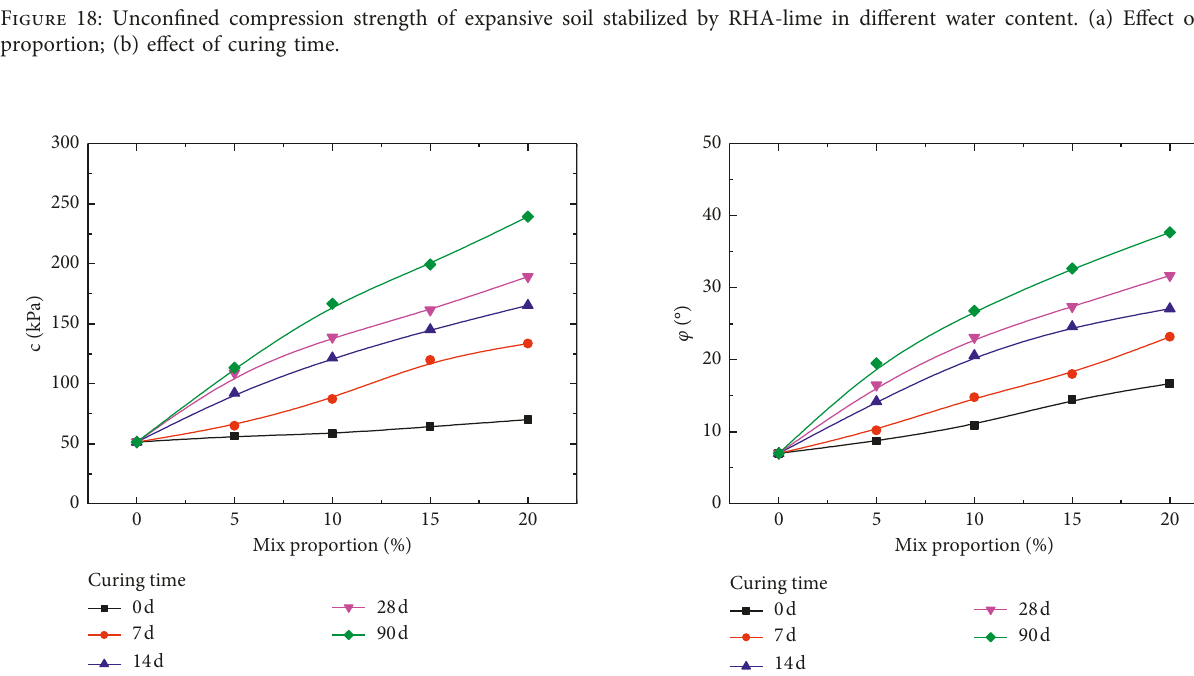
Figure 19: Cohesion of expansive soil stabilized by RHA-lime. Figure 20: Internal friction angle of expansive soil stabilized by